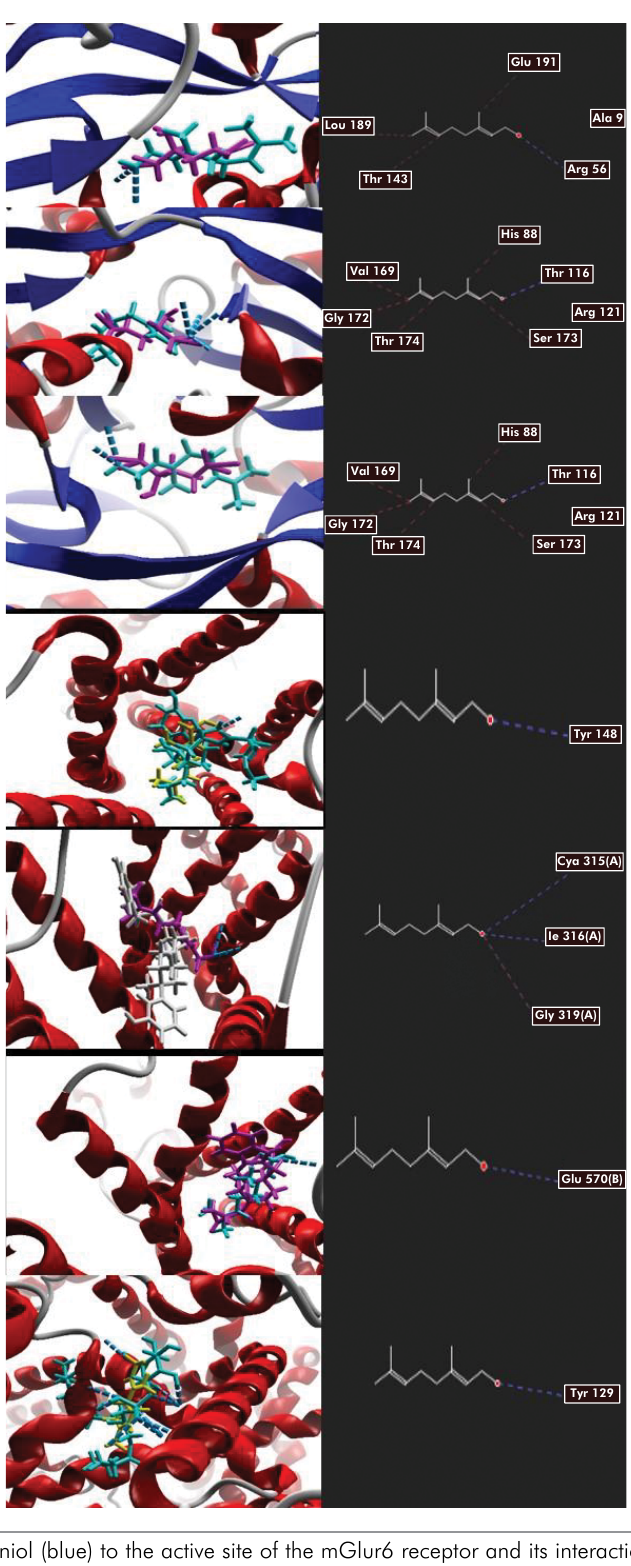
Figure 5. A - Binding of geraniol (blue) to the active site of the mGlur6 receptor and its interactions. B - Interaction of geraniol (blue) on the active site of NMDA. C - Interaction of geraniol (blue) on the active site of AMPA. D - Interaction of geraniol (blue) on the active site of AMPA. E - Interaction of geraniol (pink) on the active site of opioid k. F - Interaction of geraniol (blue) on the active site of opioid δ . G - Interaction of geraniol (yellow) on the active site of